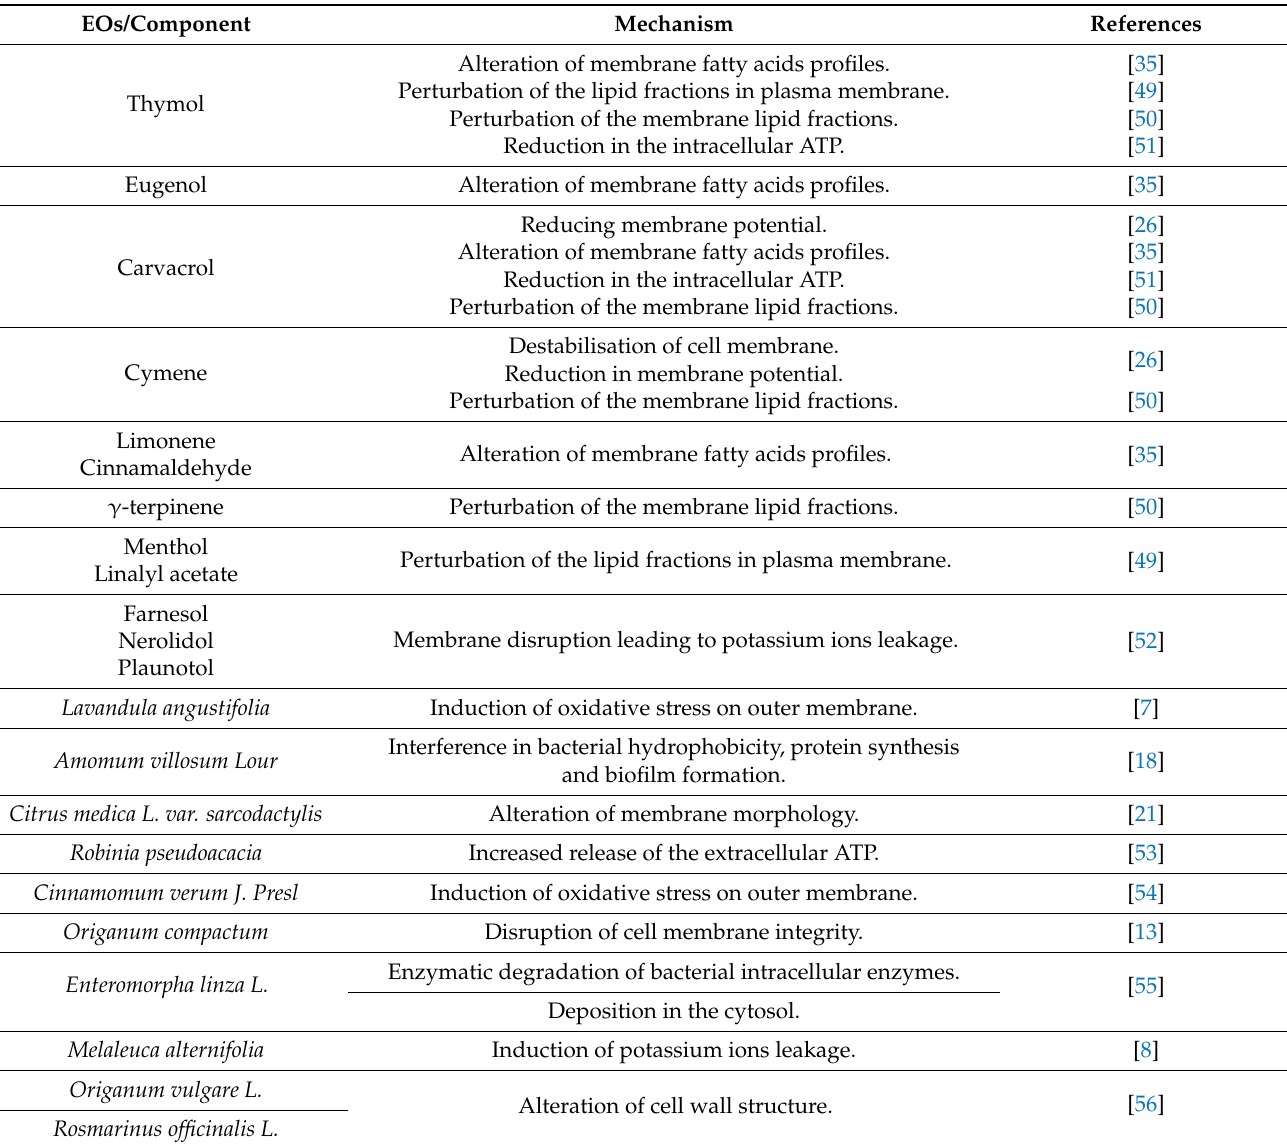
Table 1. Essential oils (Eos) and components with membrane